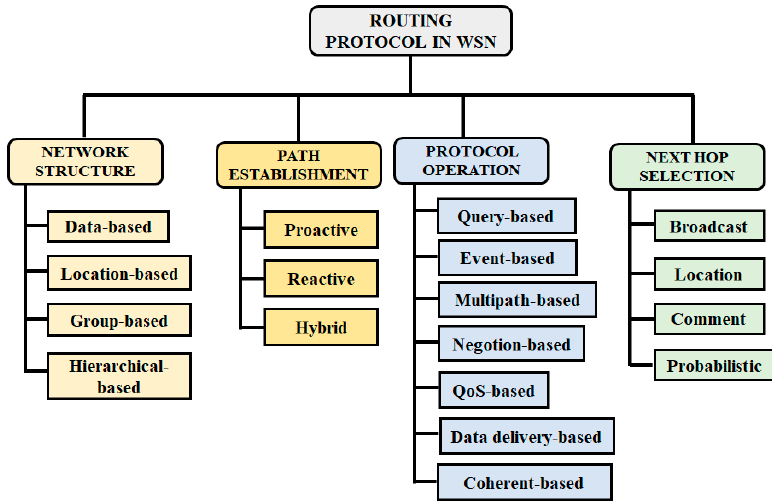
Figure 1. Classification of routing protocol in a Wireless Sensor Network (WSN).